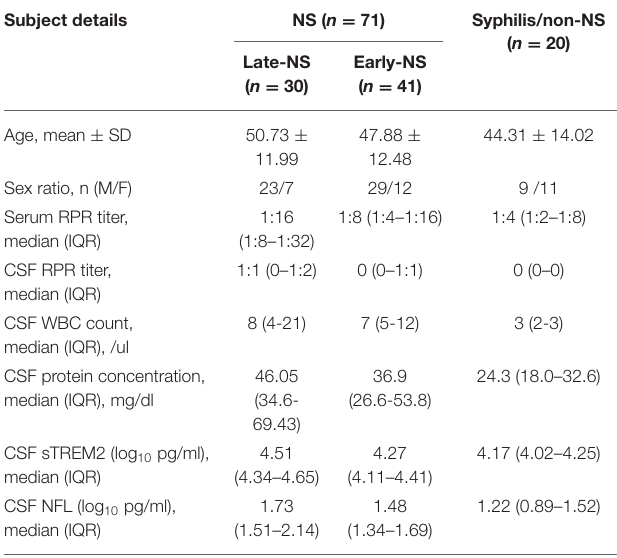
TABLE 1 | Characteristics of patients with the NS patients and Syphilis/non-NS